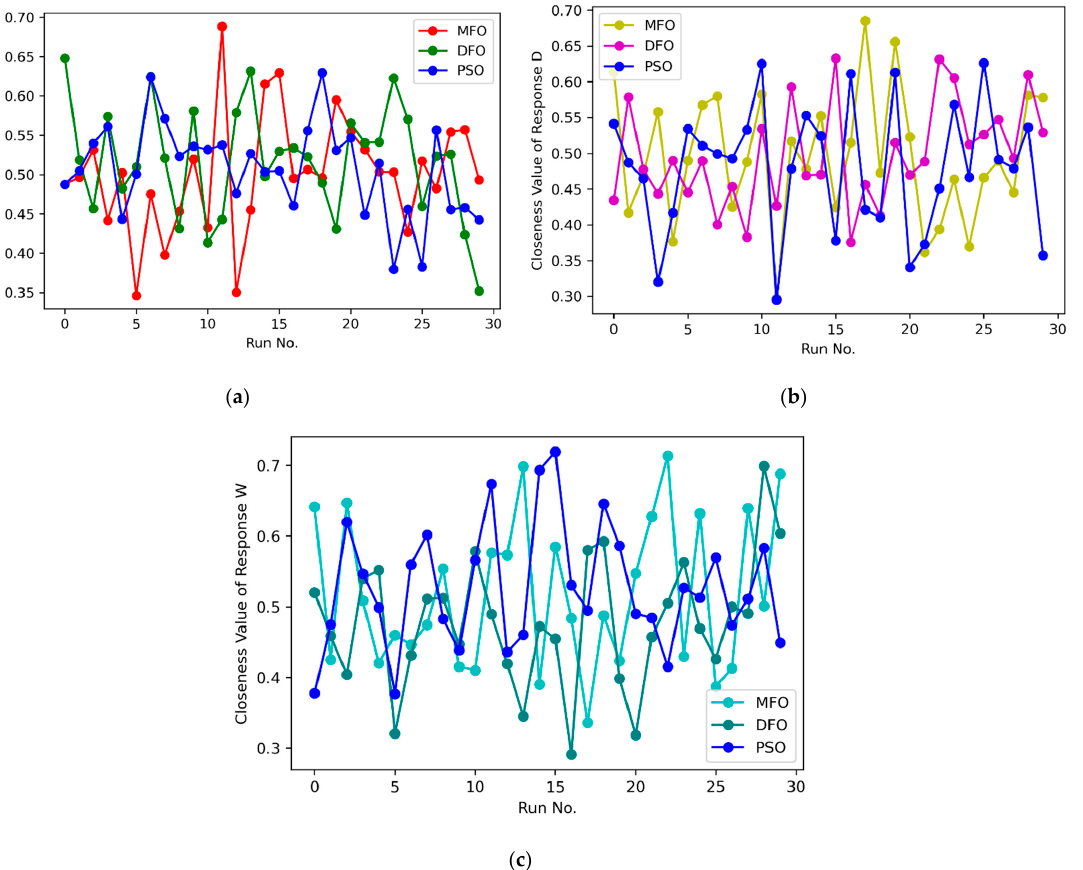
Figure 5 . Comparison of closeness values for ( a ) Response L; ( b ) Response D; ( c ) Response W. Table 9. Best Parameters of the SVR model for responses L, D, and W.